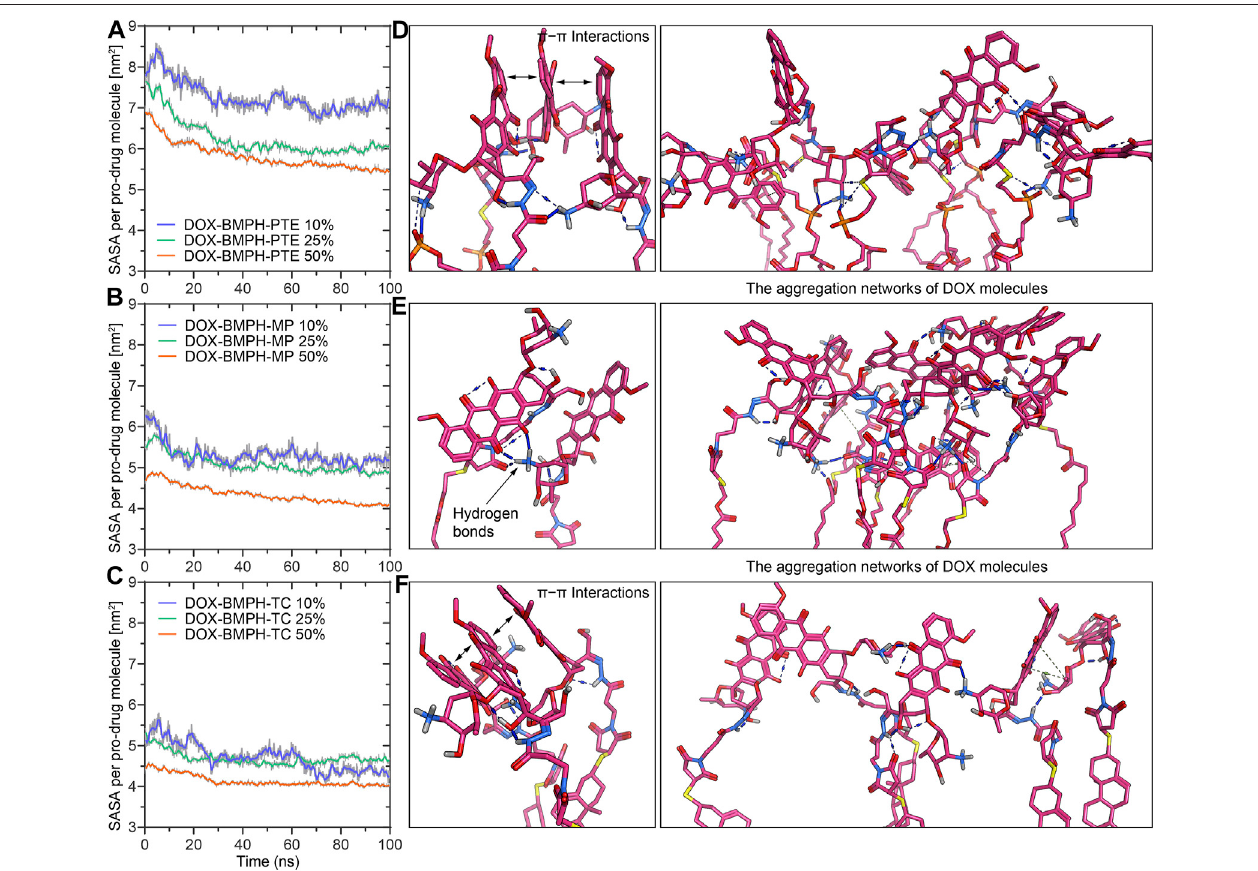
FIGURE6| MDsimulationanalysisofthesolventaccessiblesurfacearea(SASA)andself-aggregationbehaviorofDOX-prodrugNDformulations.Timeevolutionof theSASAperprodrugmoleculeduring100nsofMDsimulationforNDformulationsof (A) DOX-BMPH-PTE. (B) DOX-BMPH-MP. (C) DOX-BMPH-TC.Theaggregation networks of DOX molecules in ND formulations of (D) DOX-BMPH-PTE. (E) DOX-BMPH-MP. (F) DOX-BMPH-TC. Overall Stability and Flexibility of MSP1 Protein Assembled with Different DOX-ND Formulations.